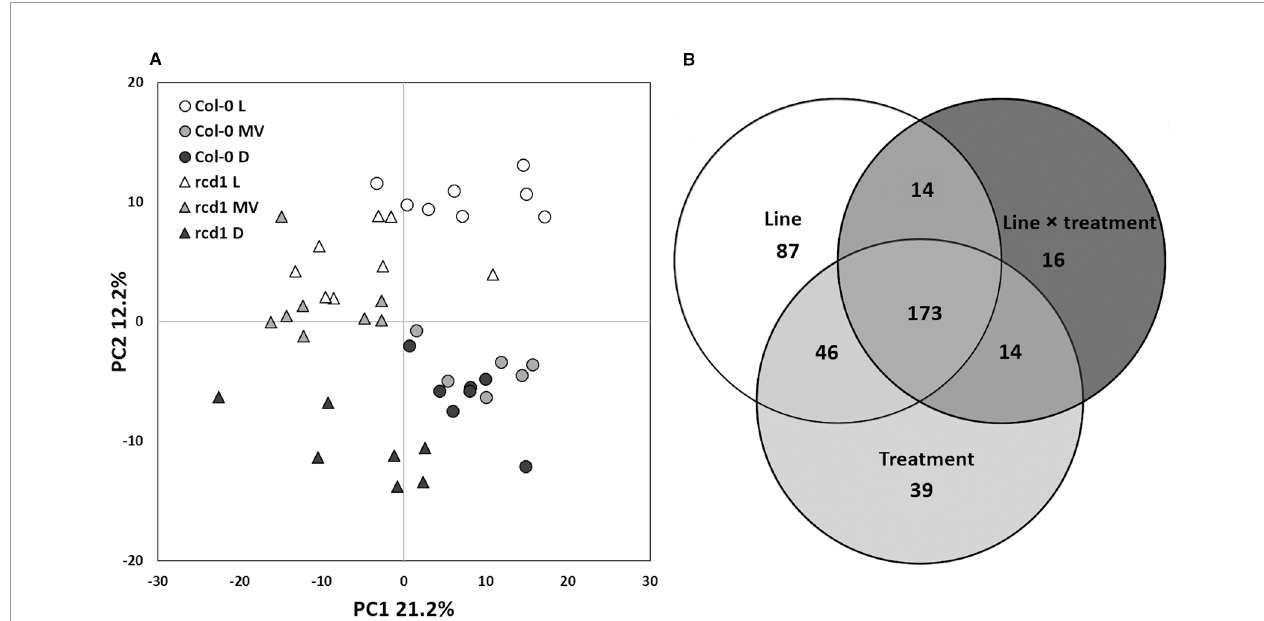
FIGURE 1 | (A) Statistical analysis of GC-MS metabolite data of Col-0 and rcd1 plants. Scores plot of principal component analysis of 489 metabolites. The fi rst principal component separates the two plant lines and treatments are separated based on the second principal component, n = 6 – 8. Symbols and colors indicate different plant lines and conditions: circle and triangle indicate Col-0 and rcd1 , and white, light gray and black indicate light/control (L), paraquat exposure (MV) and dark (D) conditions, respectively. (B) Venn diagram shows statistically signi fi cant effects of plant line (white), treatment (light gray) and line×treatment (dark gray) interaction on metabolite levels, two-way ANOVA, p < 0.05). The details of statistical results and the list of metabolites are in Supplementary Tables S1 and S3